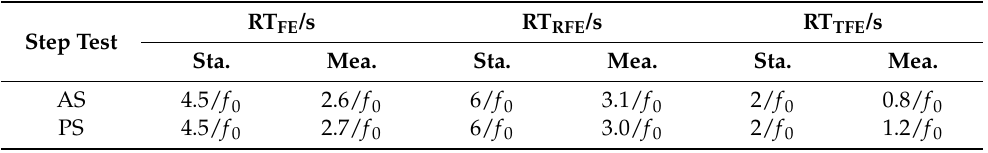
Table 3. Response Times under the Step Test.